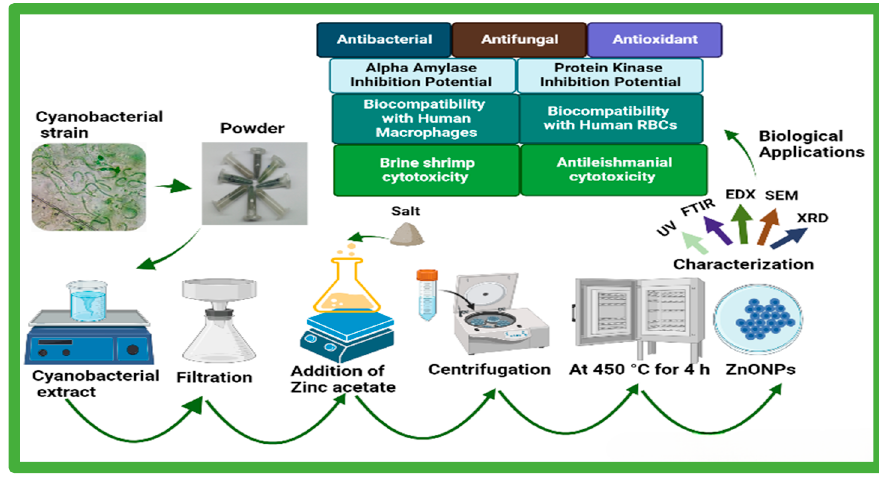
Figure 10. Study scheme showing the biosynthesis, characterization, and biological activities of zinc oxide NPs.